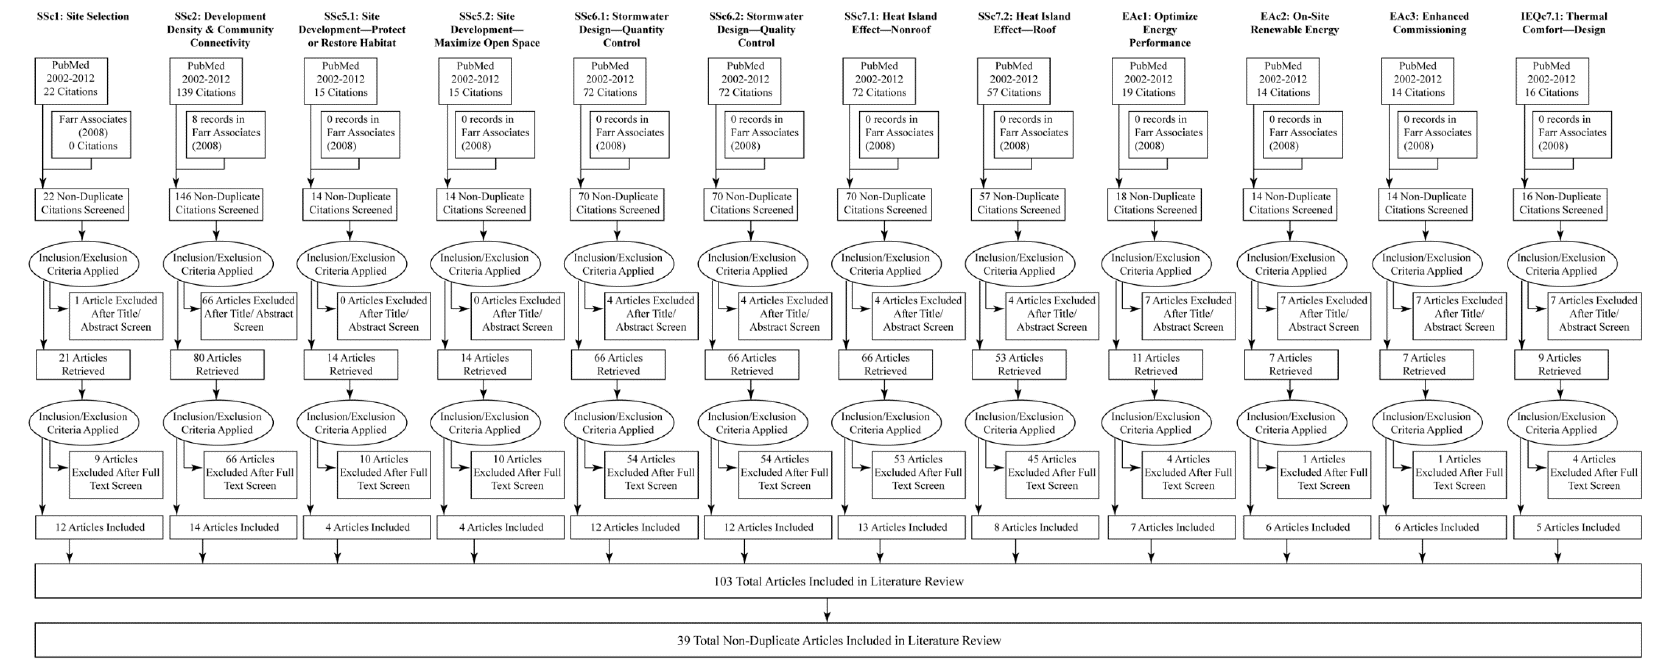
Figure A2. Flow chart of extreme heat systematic review article inclusion criteria. Source: Moher, D.; Liberati, A.; Tetzlaff, J.; Altman, D.G.; Altman, D.; Antes, G.; Atkins, D.; Barbour, V.; Barrowman, N.; Berlin, J.A.; et al. Preferred reporting items for systematic reviews and meta-analyses: The PRISMA statement [26].